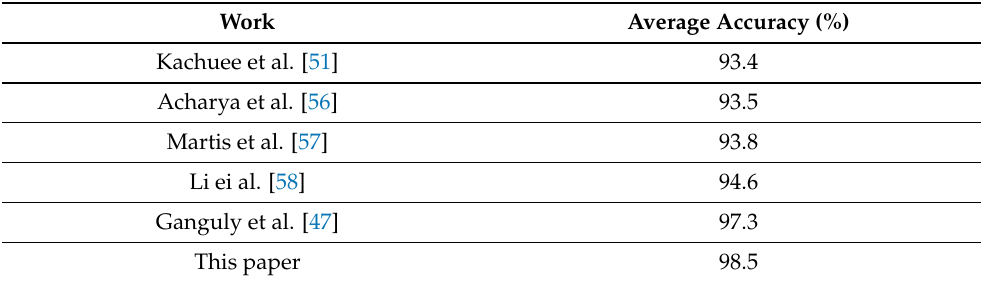
Table 5. Comparative results in the PhysioNet MIT-BIH Arrhythmia